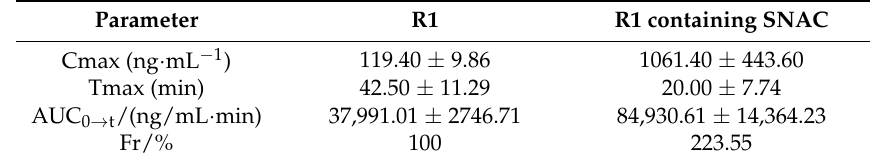
Table 1. Pharmacokinetic parameters of R1 after oral administration of R1 and R1 containing SNAC ( n = 6).